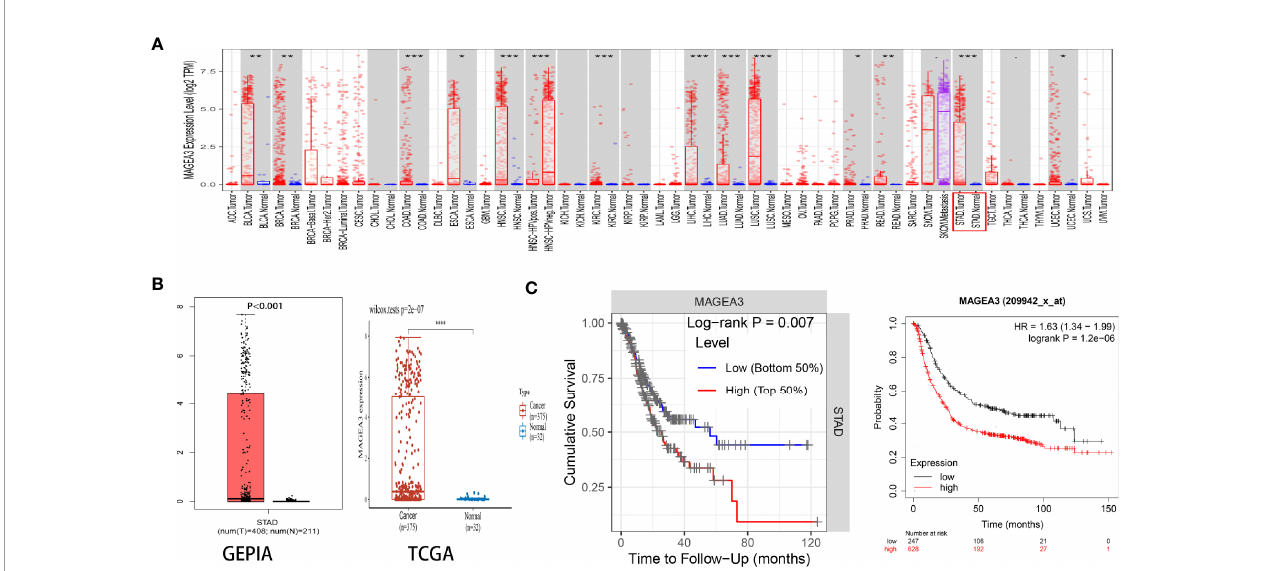
FIGURE 1 | Expression of MAGEA3 in gastric cancer. (A) MAGEA3 expression in different types of cancer was investigated with the TIMER database. (B) Increased expression of MAGEA3 in gastric cancer compared to normal tissues in the GEPIA and TCGA database. (C) Correlation between MAGEA3 and prognosis of gastric cancer in TIMER and Kaplan-Meier plotter database. *p < 0.05; **p < 0.01; ***p <